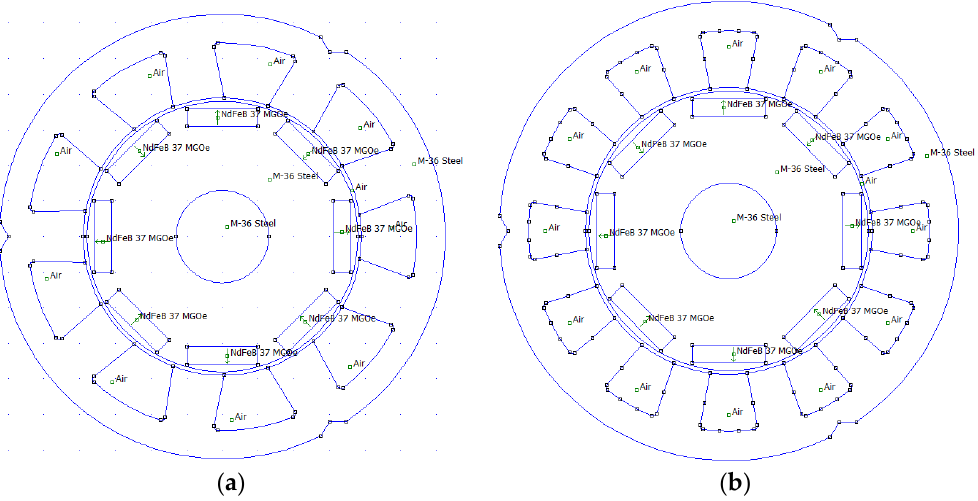
Figure 2. Basic simulation models of DCPM motors: asymmetric motor on the ( a ) and symmetric motor on ( b ).